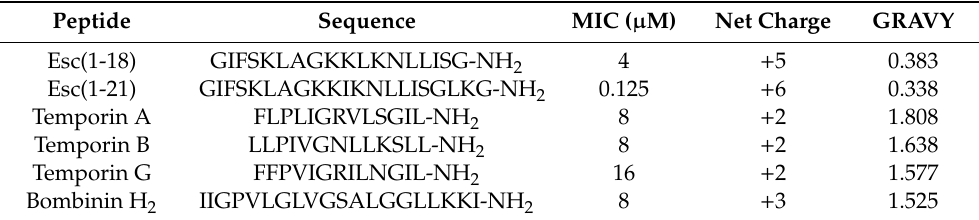
Table 1. Antimicrobial activity (MIC) of different frog skin AMPs against C. jeikeium . The net charge at neutral pH and grand average of hydropathicity (GRAVY) of each peptide are also indicated. GRAVY values were provided by https://web.expasy.org [39].